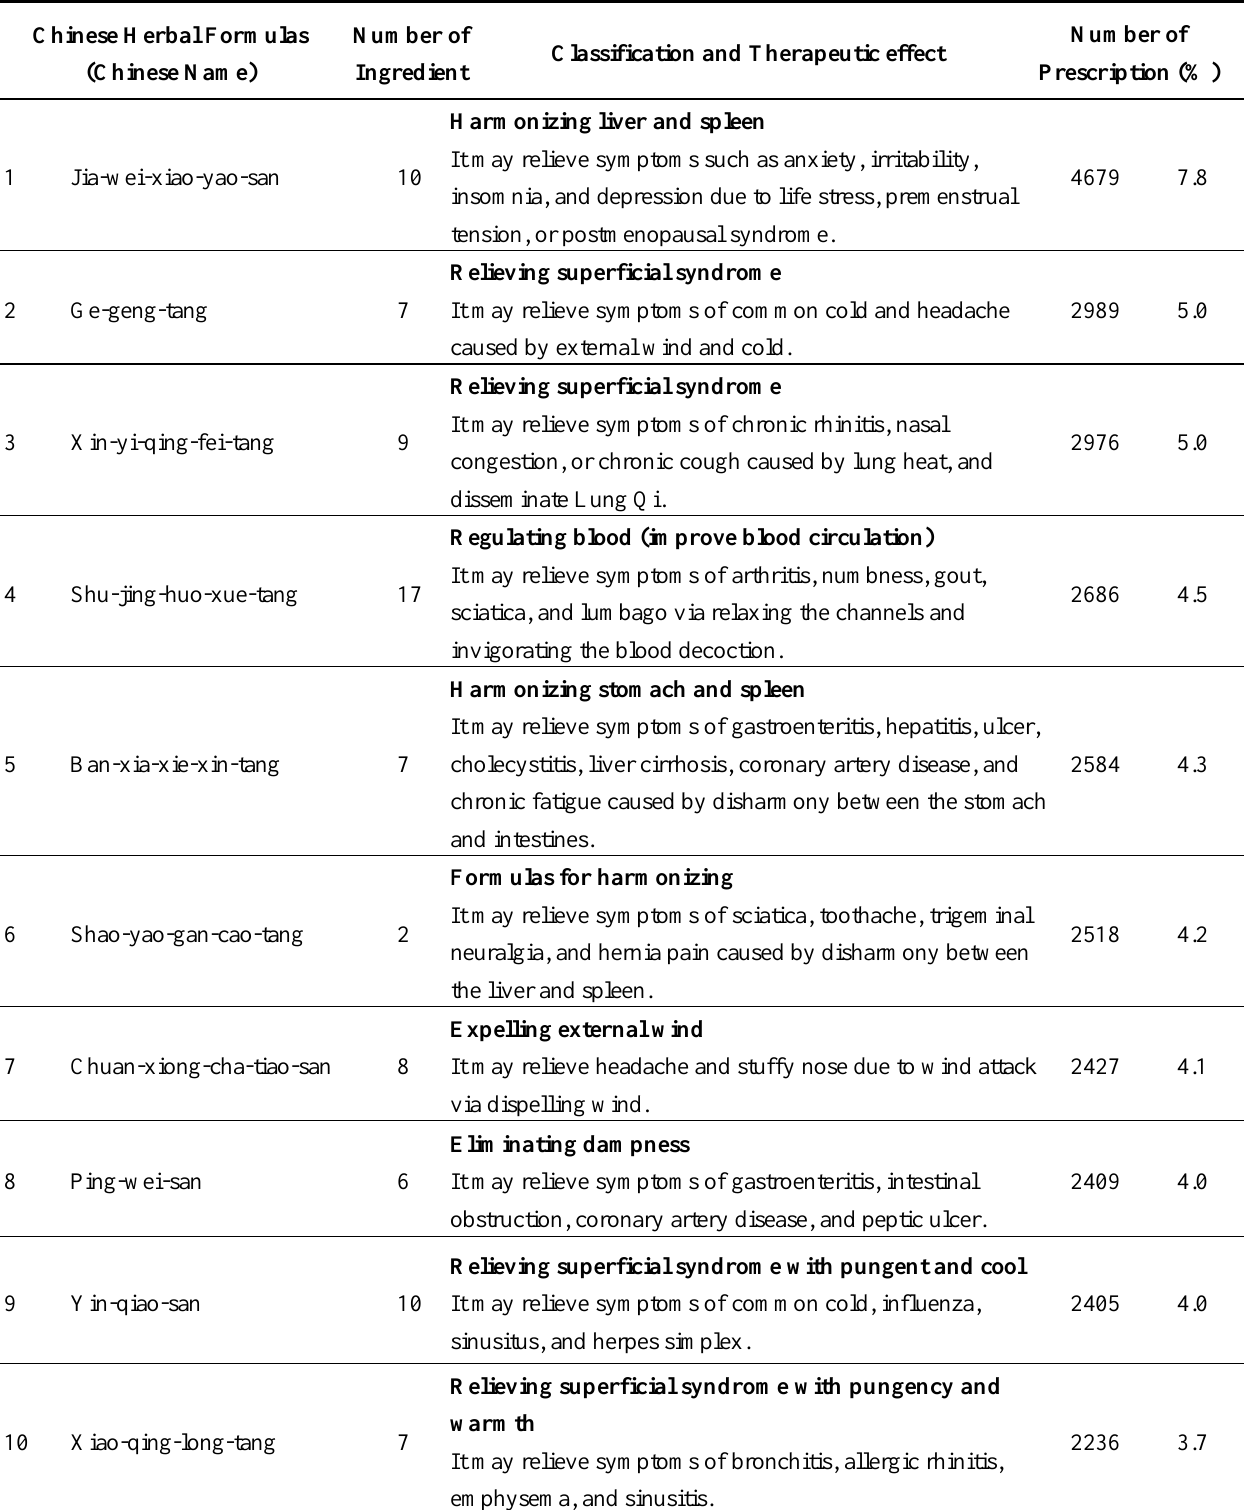
Table 3. Top 20 Chinese herbal formulas (HFs) prescribed in Taiwan in 2010 (total prescription number, n =